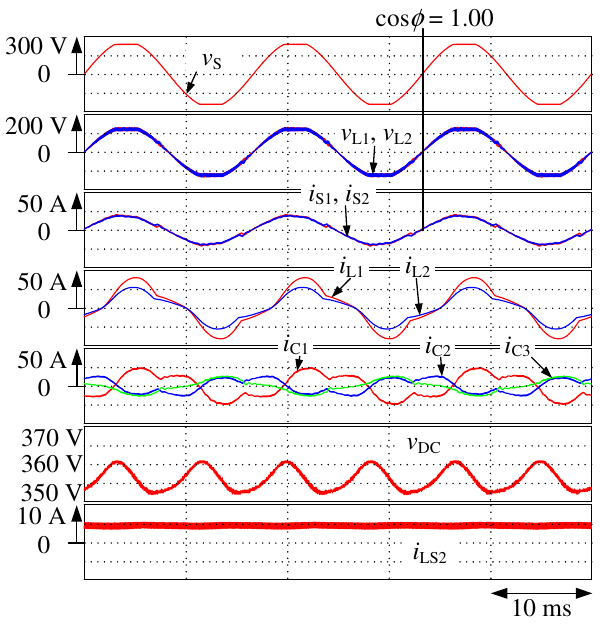
Figure 8. Experimental results for Figure 5 during battery-discharging